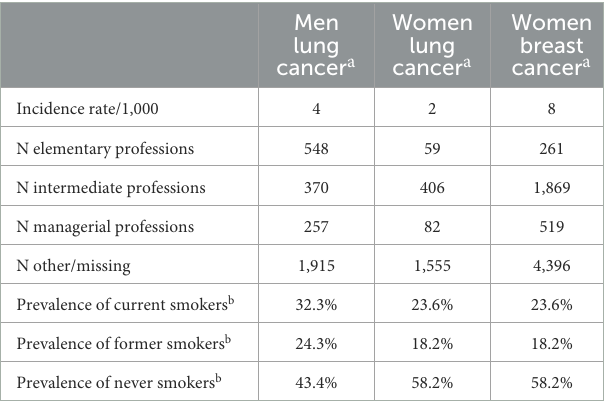
TABLE 1 Participant characteristics